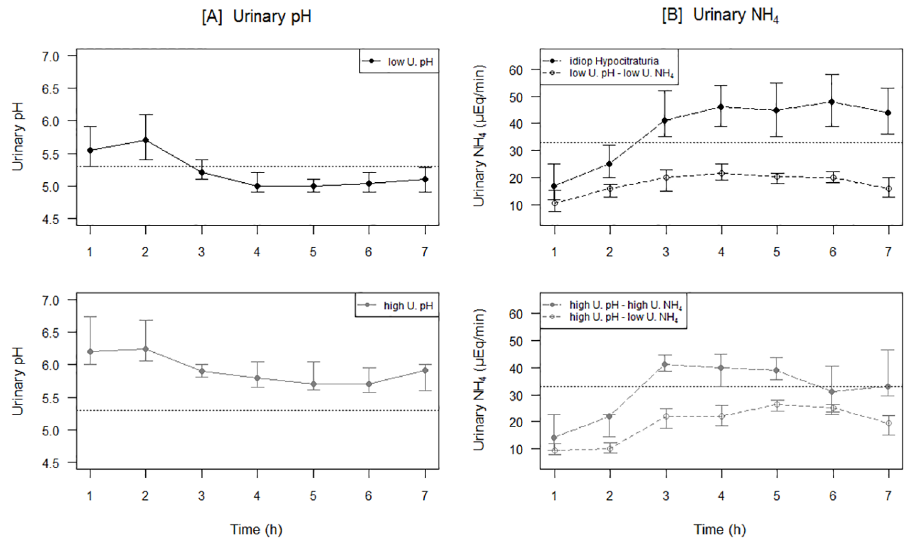
Fig 1. Urinary response to an acute acid load in patients with a normal acid-base status. A) Subdivision in 2 subgroups, accordingto the ability of the patients to decrease urinary pH below5.3 (upper panel)or not (lower panel). B) Subdivision into four subgroupsaccordingthe ability of the subjectsto decreaseurinary pH below5.3 and to reach maximal urinary ammoniumexcretion(U.NH 4+ ) to 33 μ Eq/min. Green: idiopathic hypocitraturia definedto both appropriate adaptationof both pH and U.NH 4+ ). Blue: appropriate maximal urinary ammoniumexcretionin spite of insufficienturinary acidification (high U. pH, high U.NH 4+ group); Purpura: Inappropriate urinary acidification but appropriate U.NH 4+ (high U. pH, low U.NH 4+ group); Red: Appropriate urinary acidification and U.NH 4+ (low U. pH, low U.NH 4+ group). Points represent the median value, whiskers representthe interquartile